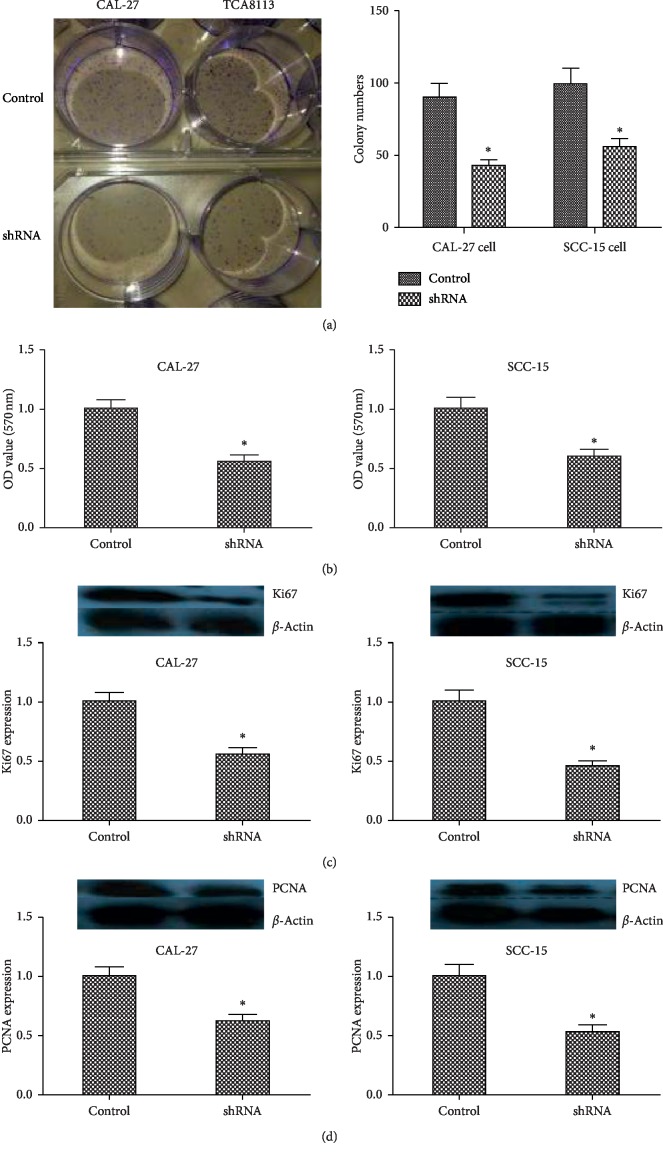
Suppression of KIF22 inhibited proliferation in CAL-27 cells and SCC-15 cells. (a) Representative images of colony formation assays of CAL-27 cells transfected with shRNA (shCAL-27) and SCC-15 cells transfected with shRNA (shSCC-15) (left). Qualification result of assays (right). (b) MTT assays of CAL-27 cells, shCAL-27 cells (left) and TCA18133 cell, shTCA18133 cells. (c) Protein expression level of ki67 in CAL-27 cells and shCAL-27 cells. Same detection in SCC-15 cells and shSCC-15 cells. (d) PCNA protein expression level in CAL-27 cells and shCAL-27 cells. Same detection in TCA18133 cells and shTCA18133 cells. Data represent mean ± SD. ∗P < 0.05.